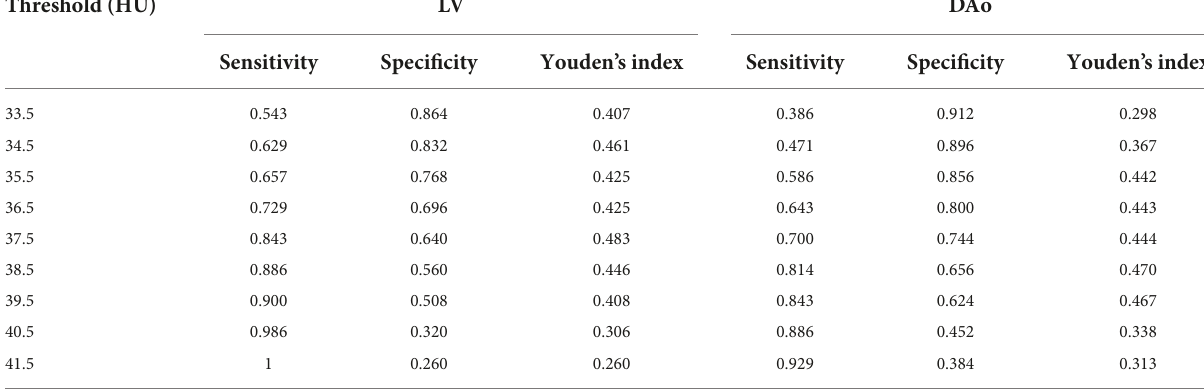
TABLE 8 ROC analysis of LV and DAo in the LDCT